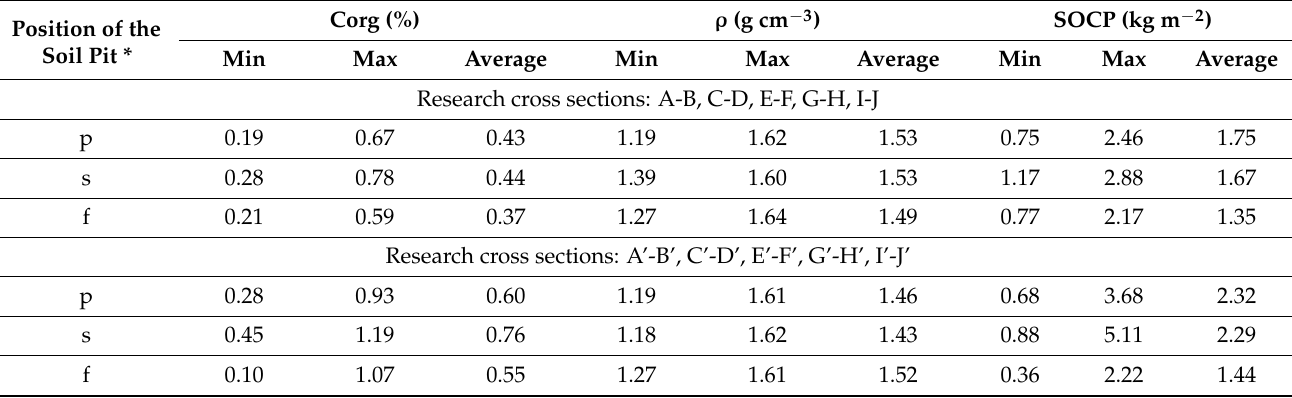
Table 2. Descriptive statistics of the soil organic carbon content, soil bulk density, and pools (stocks) of soil organic carbon accumulated in the surface layers (topsoil) along the analyzed cross sections. Position of